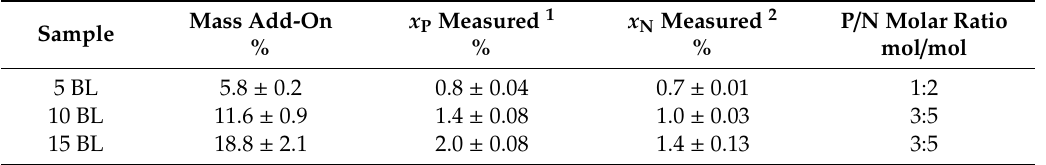
Table 1. Summary of determined mass add-on, phosphorus- and nitrogen-mass fractions x and molar P / N ratio of coated cotton